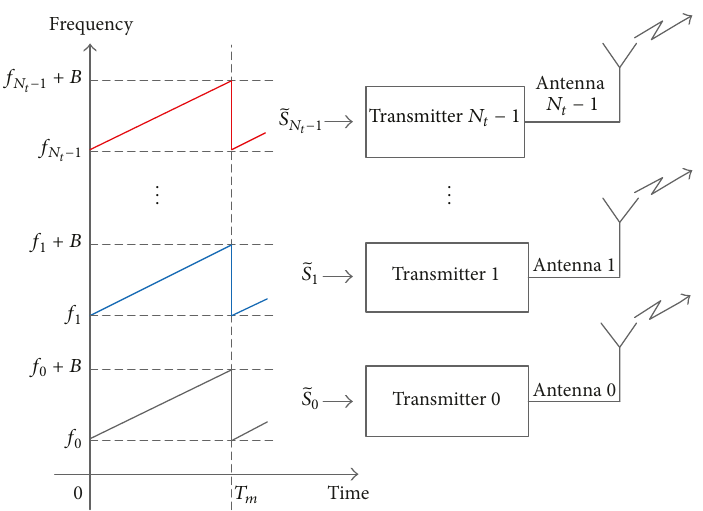
Figure 3: Time-frequency characteristic of the transmitted